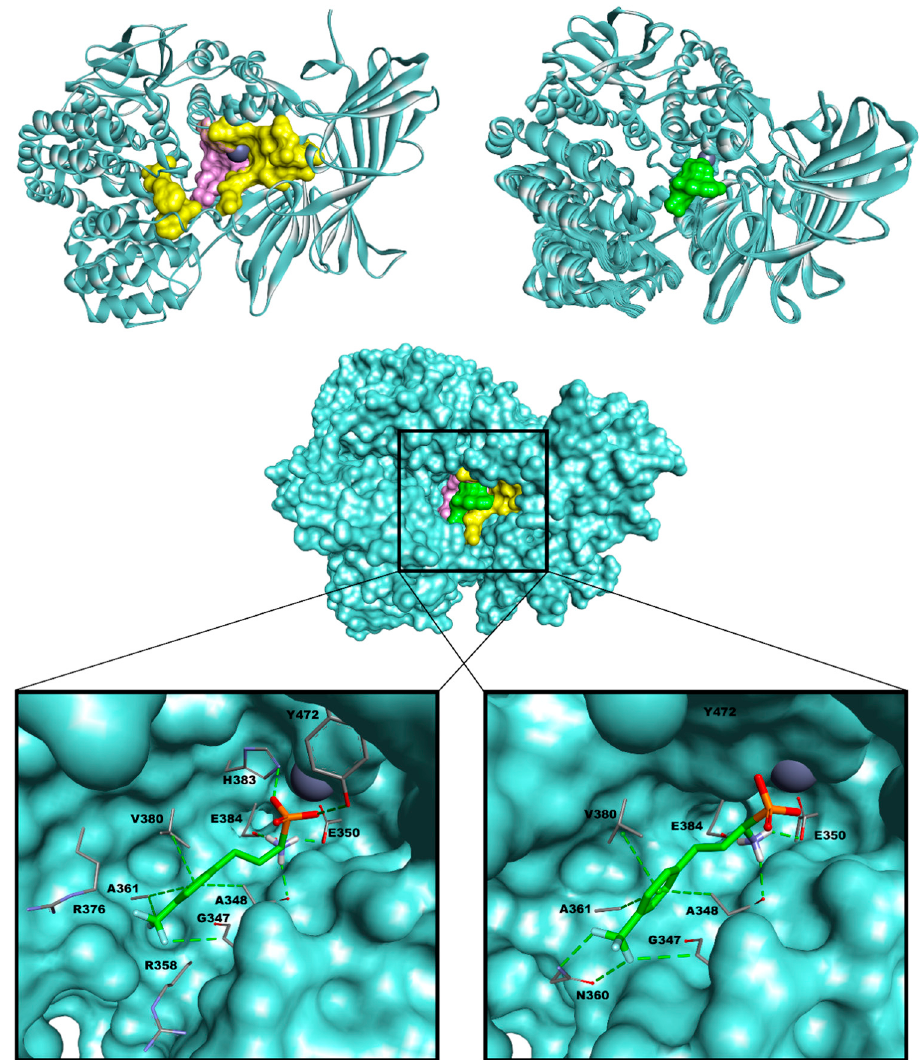
Figure 1. General view of the crystal structure of pAPN (PDB: 4FKE) with marked zinc ion, substrate binding cavities S1 (yellow) and S1 ′ (pink), in the lack and presence of inhibitor (green). An interaction between compound 15g and the active center and binding domains of the enzyme serves as representative example. The isomer (S) is shown on the left side, when the (R) -isomer on the right side. The enzyme is shown as ribbon representation, with the blue surface. The zinc atoms are shown as grey spheres. Selected amino acids and inhibitors are shown as sticks. Red color depicts oxygen atoms of the phosphonate groups and nitrogen atoms are colored blue.